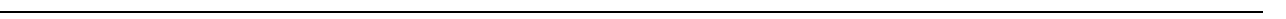
Fig. 3 TLK2 undergoes both cis - and trans -phosphorylation in the dimer. a Hierarchical clustering analysis of the phosphorylation sites of the Δ N-TLK2 constructs expressed in E. coli displayed in a heat map. Log-transformed and row-normalized intensities of phosphosites are shown in triplicates for the heterodimer kinase-dead subunit (HeteroKD), the heterodimer active subunit (Hetero), the active homodimer ( Δ N-TLK2) and the kinase-dead homodimer ( Δ N-TLK2-KD). b Volcano plot validation showing the regulation and signi fi cance of phosphosites between the Δ N-TLK2 homodimer and the kinase-dead Δ N-TLK2-KD homodimer. Phosphosites are labelled in black (signi fi cant), light orange (highly signi fi cant) and red (most highly signi fi cant). c All detected phosphorylation sites mapped on the Δ N-TLK2 domain scheme. The drawing does not imply a parallel arrangement of the dimer. Sites cannot be assigned to individual molecules of the dimer. Boxed phosphosites have been detected in both HEK293 and E. coli -expressed Δ N-TLK2, while unboxed sites were only found in the E. coli -expressed Δ N-TLK2. Font colour represents signi fi cance as shown in Fig. 3b for the E. coli -expressed Δ N-TLK2 (black, light orange and red). The unboxed green sites represent phosphosites observed exclusively in the Δ N-TLK2 expressed in HEK293 cells. d Schematic representation depicting the unique phosphorylation sites observed in the heterodimer Δ N-TLK2 active subunit and in the Δ N-TLK2-KD kinase-dead subunit. The phosphorylation sites in T208, T213, S218, S226, S289, T300, S307, T357, T380, S761 and T762 were observed in both subunits of the heterodimer (see Supplementary Data 1 and Fig. 6a – d for volcano plots displaying distributions of peptides when comparing the different